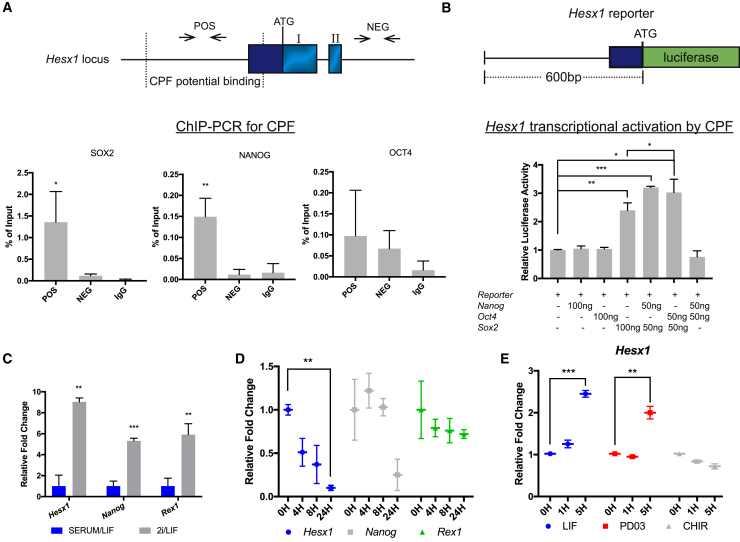
Hesx1 Expression in ESCs Is Regulated by Naive Pluripotency-Promoting Signals(A) ChIP-PCR showing the binding of SOX2, NANOG, and OCT3/4 to the Hesx1 promoter (n = 3 experiments). Diagram depicting part of the Hesx1 locus, where POS is the region reported to be occupied by core pluripotency factors (CPF) and NEG represents a region in which binding was not reported.(B) Schematic diagram of the firefly luciferase reporter used in the co-transfection experiments in HEK-293T cells. Synergistic activation of Hesx1 transcription by SOX2, NANOG, and OCT3/4 (n = 3 experiments).(C) qRT-PCR for Hesx1, Nanog, and Rex1 expression in 2iLIF relative to serum/LIF (n = 3 experiments).(D) qRT-PCR for Hesx1, Nanog, and Rex1 expression upon removal of the PD03 and CHIR (2i). Point 0H represents cells in 2i prior to inhibitor withdrawal (n = 3 experiments).(E) qRT-PCR showing that Hesx1 expression is rapidly upregulated in WT ESCs upon LIF stimulation and MEK inhibition. Point 0H represents cells after a starvation period of 12 h in serum-free medium (n = 3 experiments).